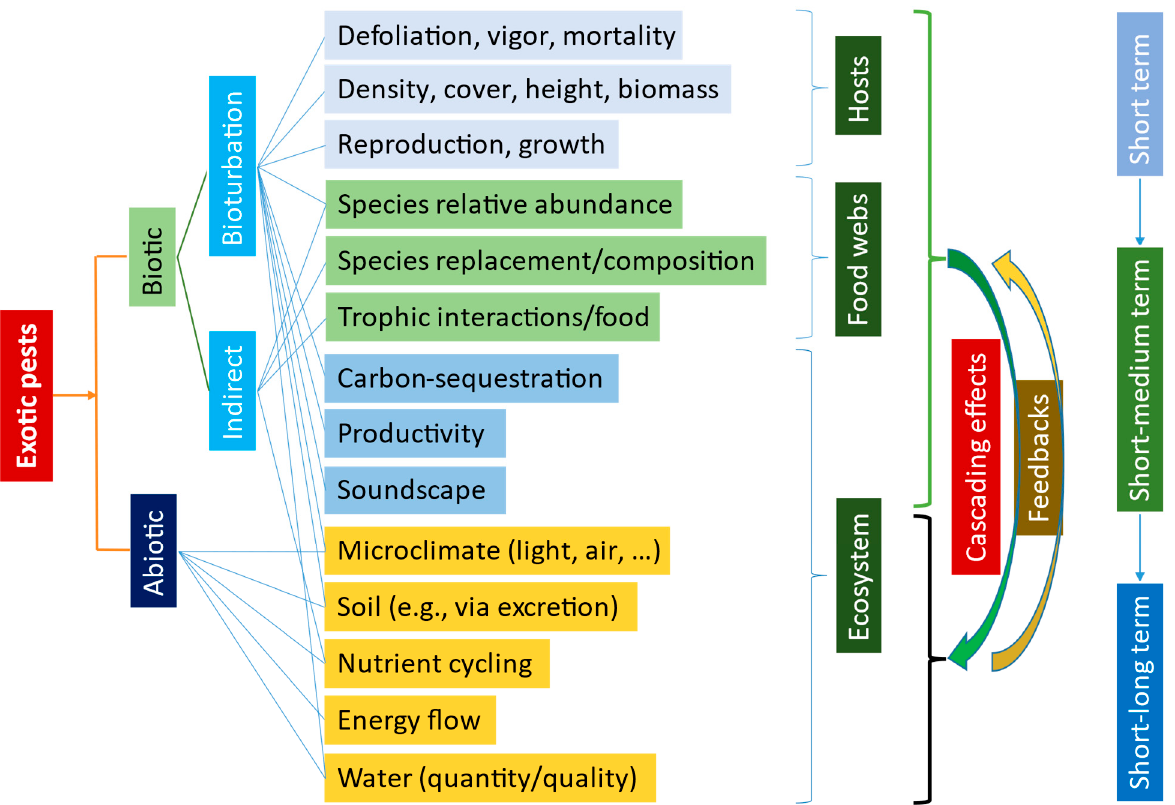
Figure 2. Examples of how exotic pests may initiate short-medium-long-term effects on community- and ecosystem-level patterns and processes. Impacts of exotic pests on ecosystems can both be direct and indirect (e.g., pest-induced changes in trees at the individual, population, and community levels), which could eventually lead to landscape-level changes (Lázaro-Lobo and Ervin 2021). Feedback effects could be found at all organization levels, although varying time legs may also exist.